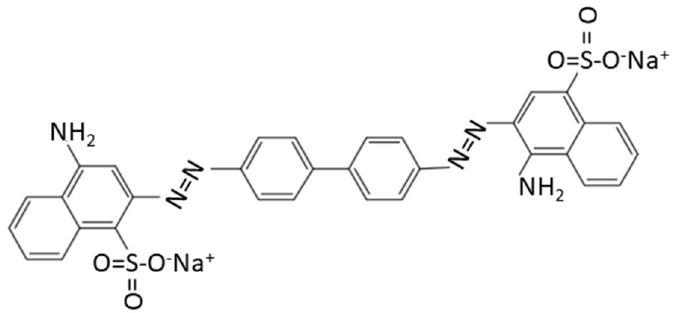
Figure 1. Molecular structure of CR.